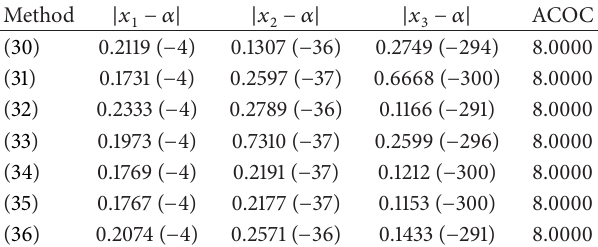
Table 4: Numerical results with 𝑓 4